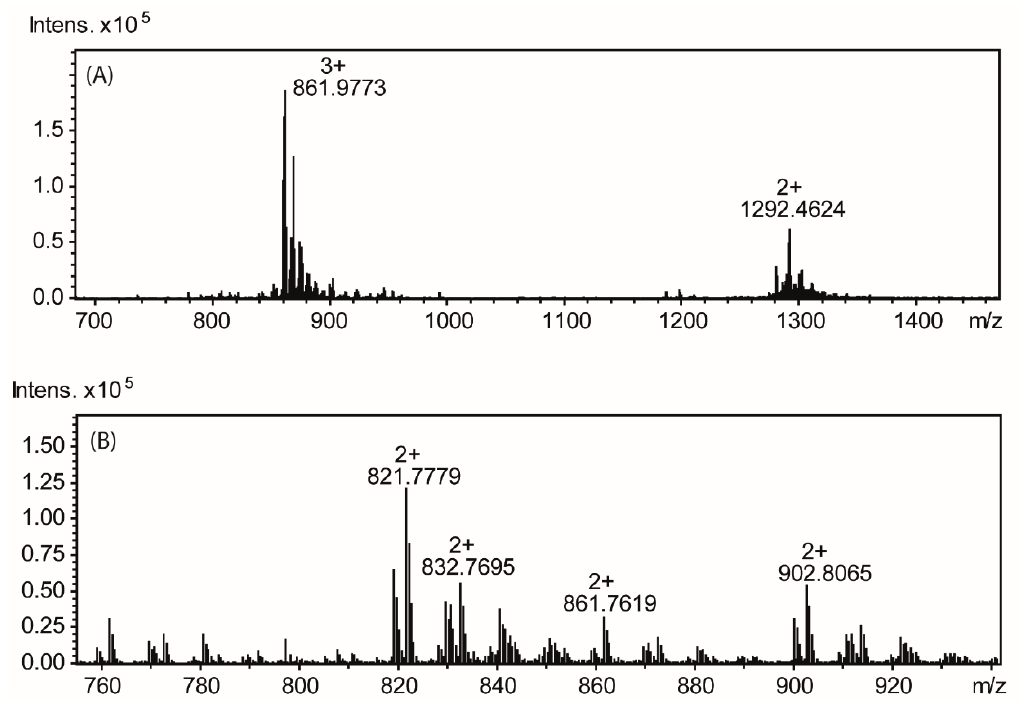
Figure 4. Mass spectra of ( A ) the OSI fraction containing the core oligosaccharide substituted by one repeating unit ( B ) the OSII fraction containing the unsubstituted core oligosaccharide. The 1 H-NMR and 1 H, 13 C-HSQC (Figure 5) spectra of the OSII fraction contained eight main signals in the region for anomeric protons and carbons as well as signals characteristic for the deoxy protons of a Kdo residue, indicating a nonasaccharide core structure. The sugar residues are designated as E – M according to decreasing proton chemical shift values as shown in Figure 4 with δ H /δ C 5.45/101.1 ppm (residue E ), δ H /δ C 5.32/99.9 ppm (residue F ), δ H /δ C 5.21/96.50 ppm (residue G ), δ H /δ C 5.12/100.9 ppm (residue H ), δ H /δ C 4.93/100.9 ppm (residue I ), δ H /δ C 4.59/103.4 ppm (residue J ), δ H /δ C 4.47/103.7 ppm (residue K ), δ H /δ C 4.43/104.1 ppm (residue L ). The major 1 H- and 13 C-NMR